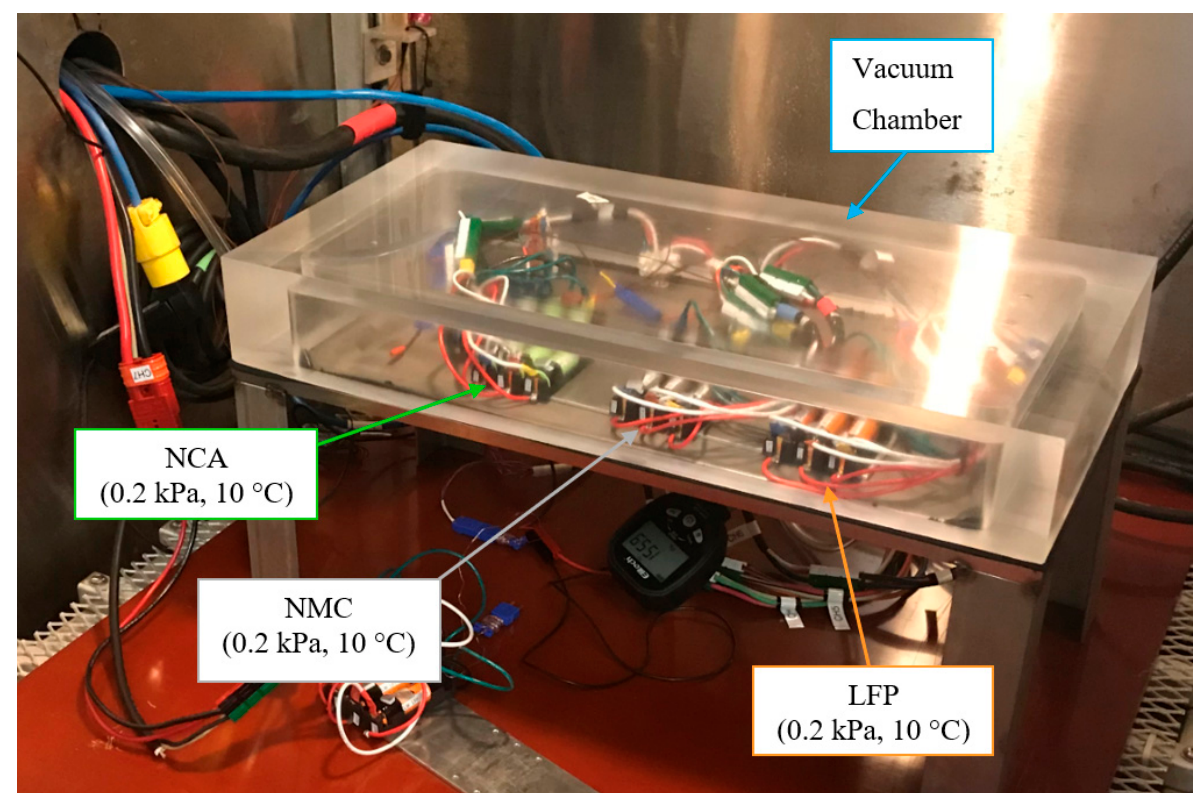
Figure 2. Experimental setup photograph of the interior of thermal chamber, with LEO condition test cells (0.2 kPa, 10 °C) in 3P groupings. Note that the test cells in the standardized condition (101 kPa, 20 °C) and low temperature condition (101 kPa, 10 °C) are not shown.